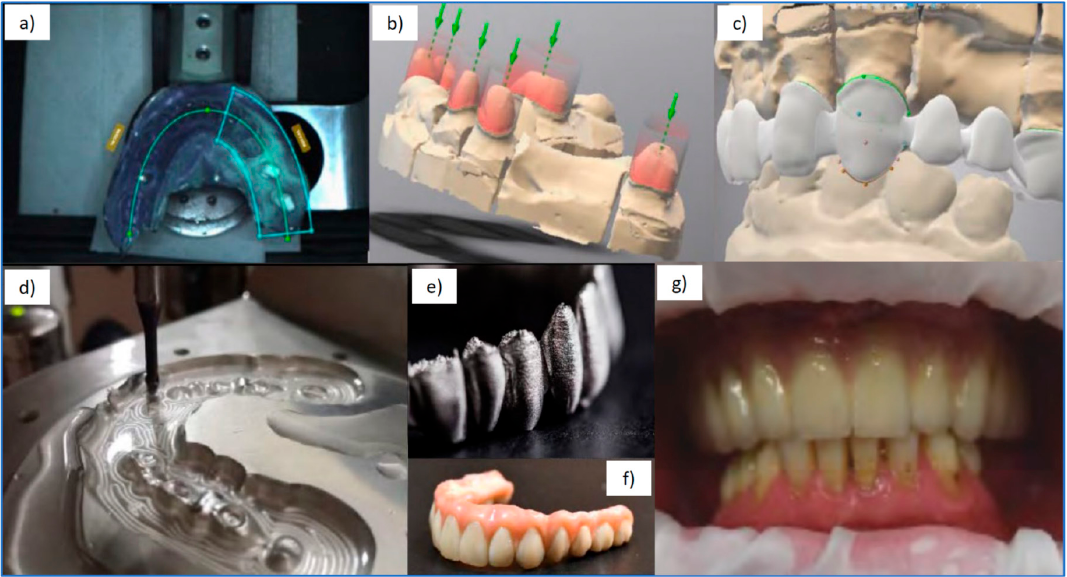
35 of 67 Figure 28. Comparison of the structure and properties of sintered Ti, sintered Ti6Al4V alloy, milled Co-Cr alloy, milled ZrO 2 sinter, and milled Ti6Al4V alloy: ( a ) comparison of the graphs of tensile stress versus elongation; ( b – e ) fracture structure after static bending test ( b , c ) Ti6Al4V solid alloy samples produced by selective laser sintering using a 50 µm laser spot after sintering at laser power ( b ) 70 W; ( c ) 110 W; ( d , e ) samples produced by the CAD/CAM method by milling disks from solid alloys: ( d ) Ti6Al4V, ( e ) Co-Cr; ( f ) view of a dental bridge made of ZrO